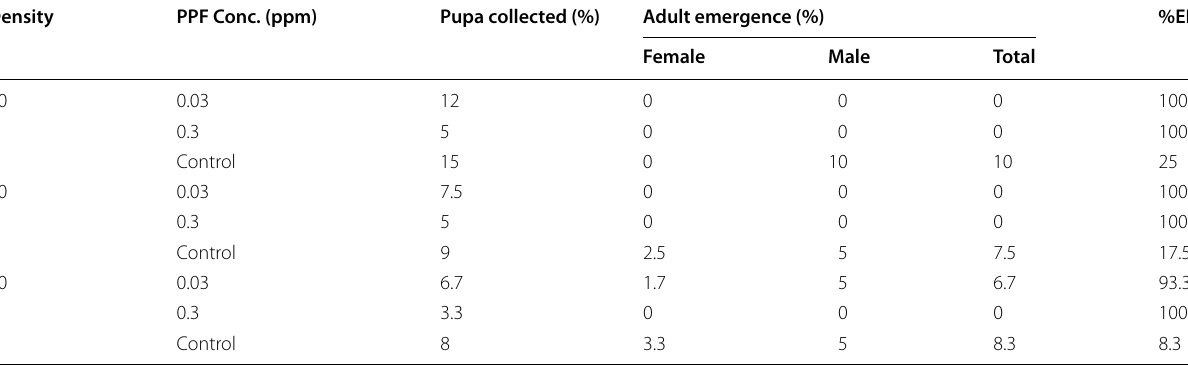
Table 2 The effect of pyriproxyfen at 0.03 ppm and 0.3 ppm on adult An. gambiae s.s. emergence in the forested area (experiments were done 6 times in 3